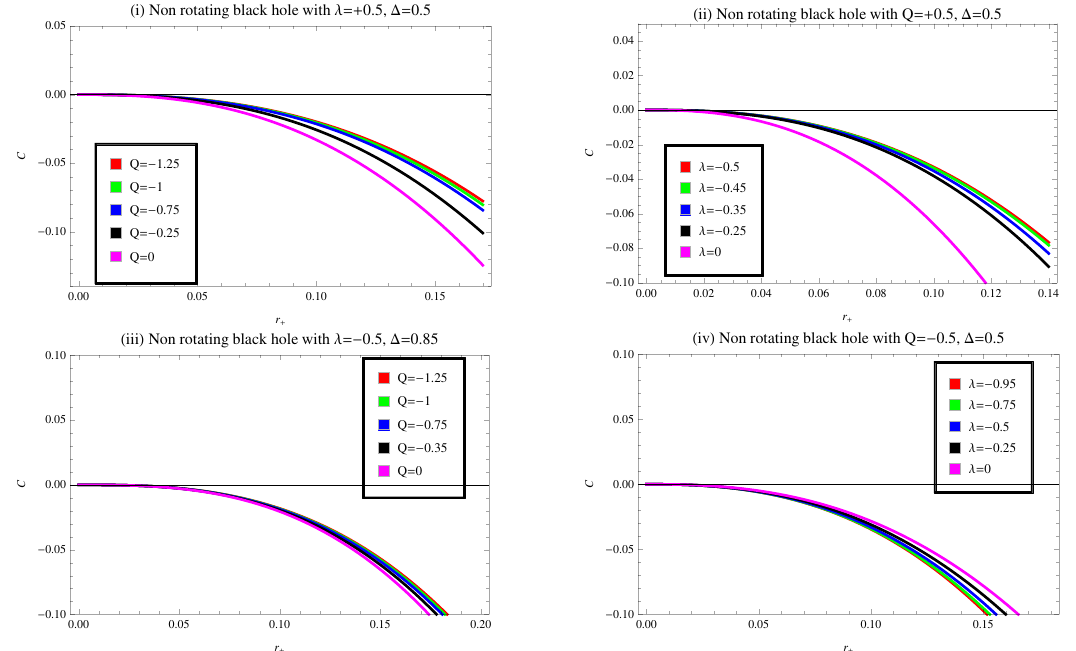
Figure 4. Plot of heat capacity C v versus horizon radius r + for non-rotating BH for various choices of λ , ∆ and Q